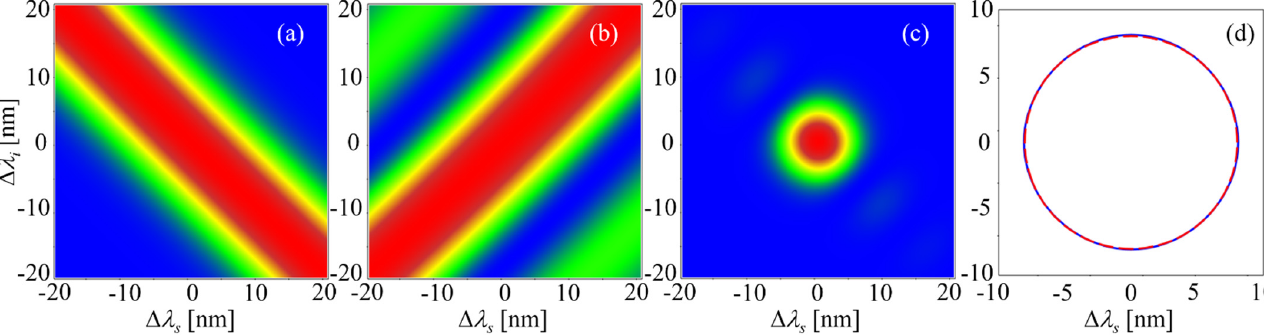
Figure 5. JSA characteristics of the SPDC output for the case of KN listed in Table 2 (i.e., λ p = 1064 nm, the maximum d eff , Type II EPM): ( a ) the pump envelope (PE) function, ( b ) the phase matching (PM) function, ( c ) the joint spectral intensity (JSI), and ( d ) the contour line for JSI = 0.5 (blue solid line) shown with a circle with a diameter of 8.1 nm (red dashed line). The spectral purity calculated using Schmidt decomposition is 0.995.